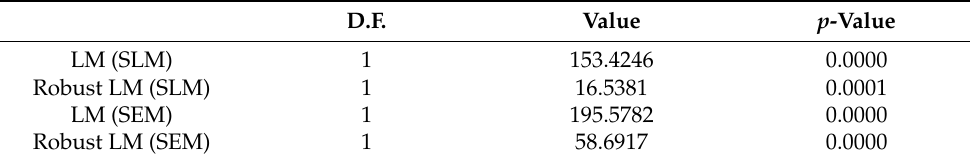
Table 3. Lagrange multiplier (LM) diagnostics for spatial